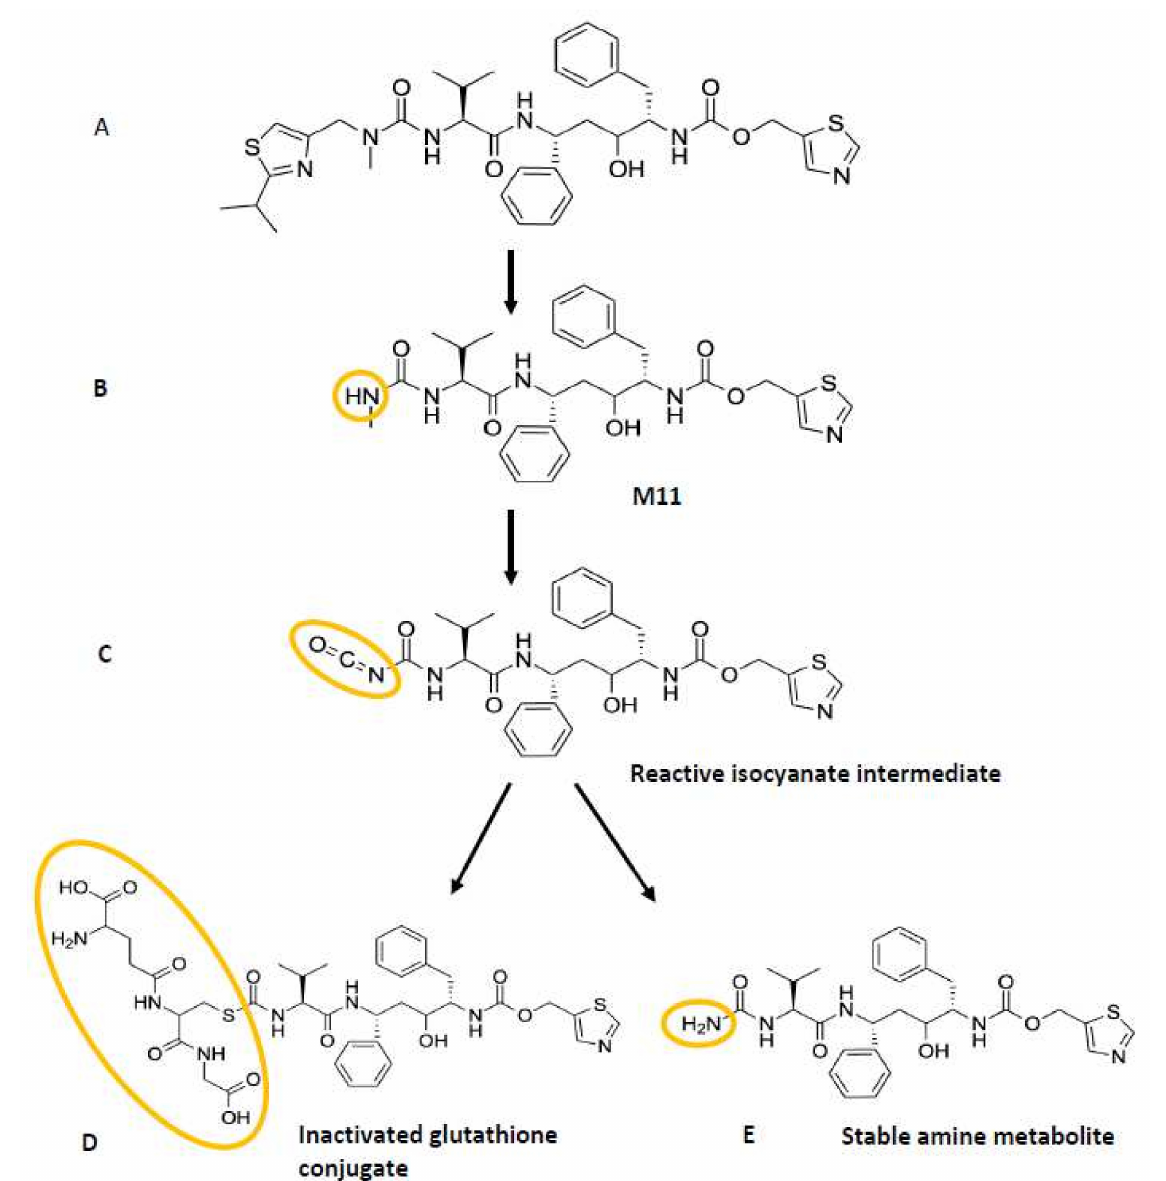
Figure 5. The proposed biotransformation scheme of the reactive isocyanate intermediate after conversion of ritonavir and further metabolism of its metabolite M11. The reactive isocyanate metabolite could be inactivated by forming a complex with GSH or could be further hydrolyzed into its stable amine metabolite. Chemical structures of ( A ) ritonavir, ( B ) M11 metabolite of ritonavir formed by loss of the isopropyl-methyl thiazole residue, ( C ) reactive isocyanate intermediate formed from the stable N-dealkylated metabolite, which has lost the HN-CH 3 moiety, ( D ) an inactivated complex of GSH and the proposed reactive intermediate, and ( E ) stable amine metabolite formed after hydrolysis and loss of the -CO 2 moiety of the reactive intermediate. The proposed reactive intermediate might initiate chemical activation of the heme group, leading to its ultimate conjugation to the CYP3A4 polypeptide [63]. The altered moieties of ritonavir in the various metabolites are highlighted in